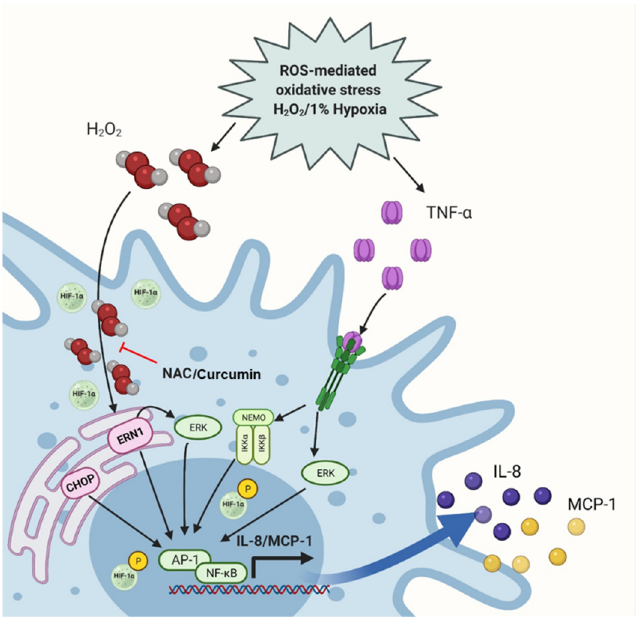
Figure 11. ROS/TNF- α crosstalk drives the IL-8 and MCP-1 expression. The schematic shows that THP-1 cell exposure to TNF- α and oxidative stress (induced by H 2 O 2 or hypoxia) promotes the intracellular ROS together with CHOP , ERN1 , and HIF1A upregulation, which leads to the NF- κ B and ERK1-2 mediated expression of IL-8 and MCP-1; while the NAC or curcumin can counteract this chemokine induction. (Created with: BioRender.com; Accessed date: 18 March 2021).